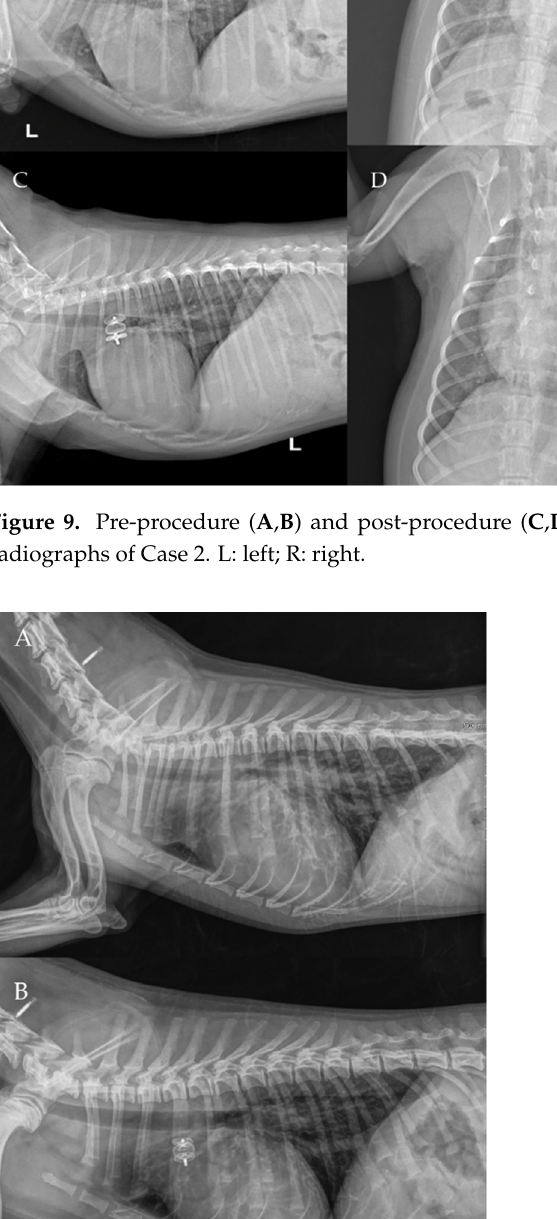
Figure 10. Pre- ( A ) and post-procedure ( B ) right lateral thoracic radiographs of Case 4.